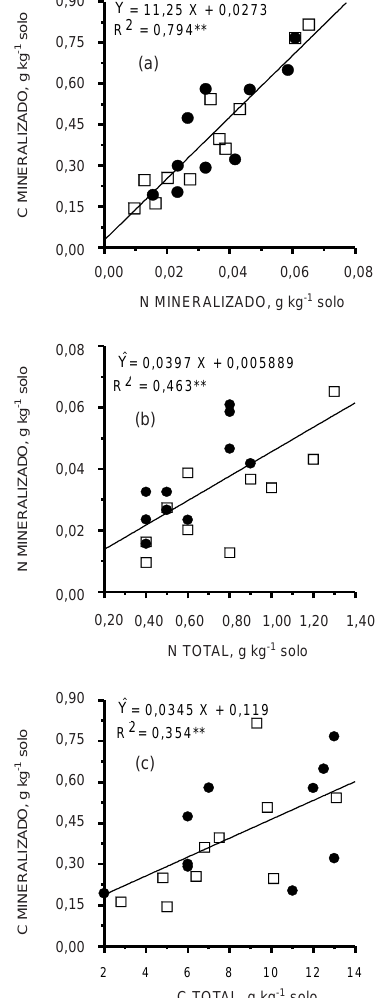
Figura 5. Relação entre os valores de C e de N mineralizados em 20 semanas de incubação (a), de N mineralizado e de N total (b) e de C mineralizado e de C total (c), em amostras das camadas de 0-20 cm de solos da zona úmida (círculos) e da zona semi-árida (quadrados) de